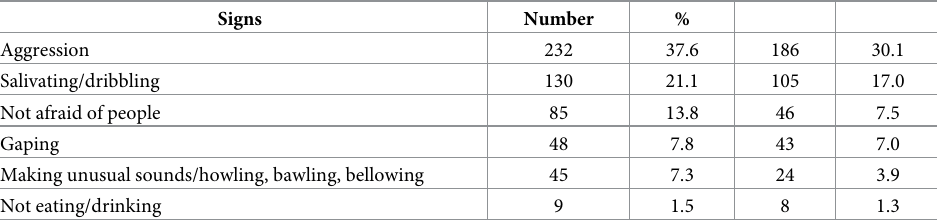
Table 3. Respondents that correctly identified signs of rabies in animals.